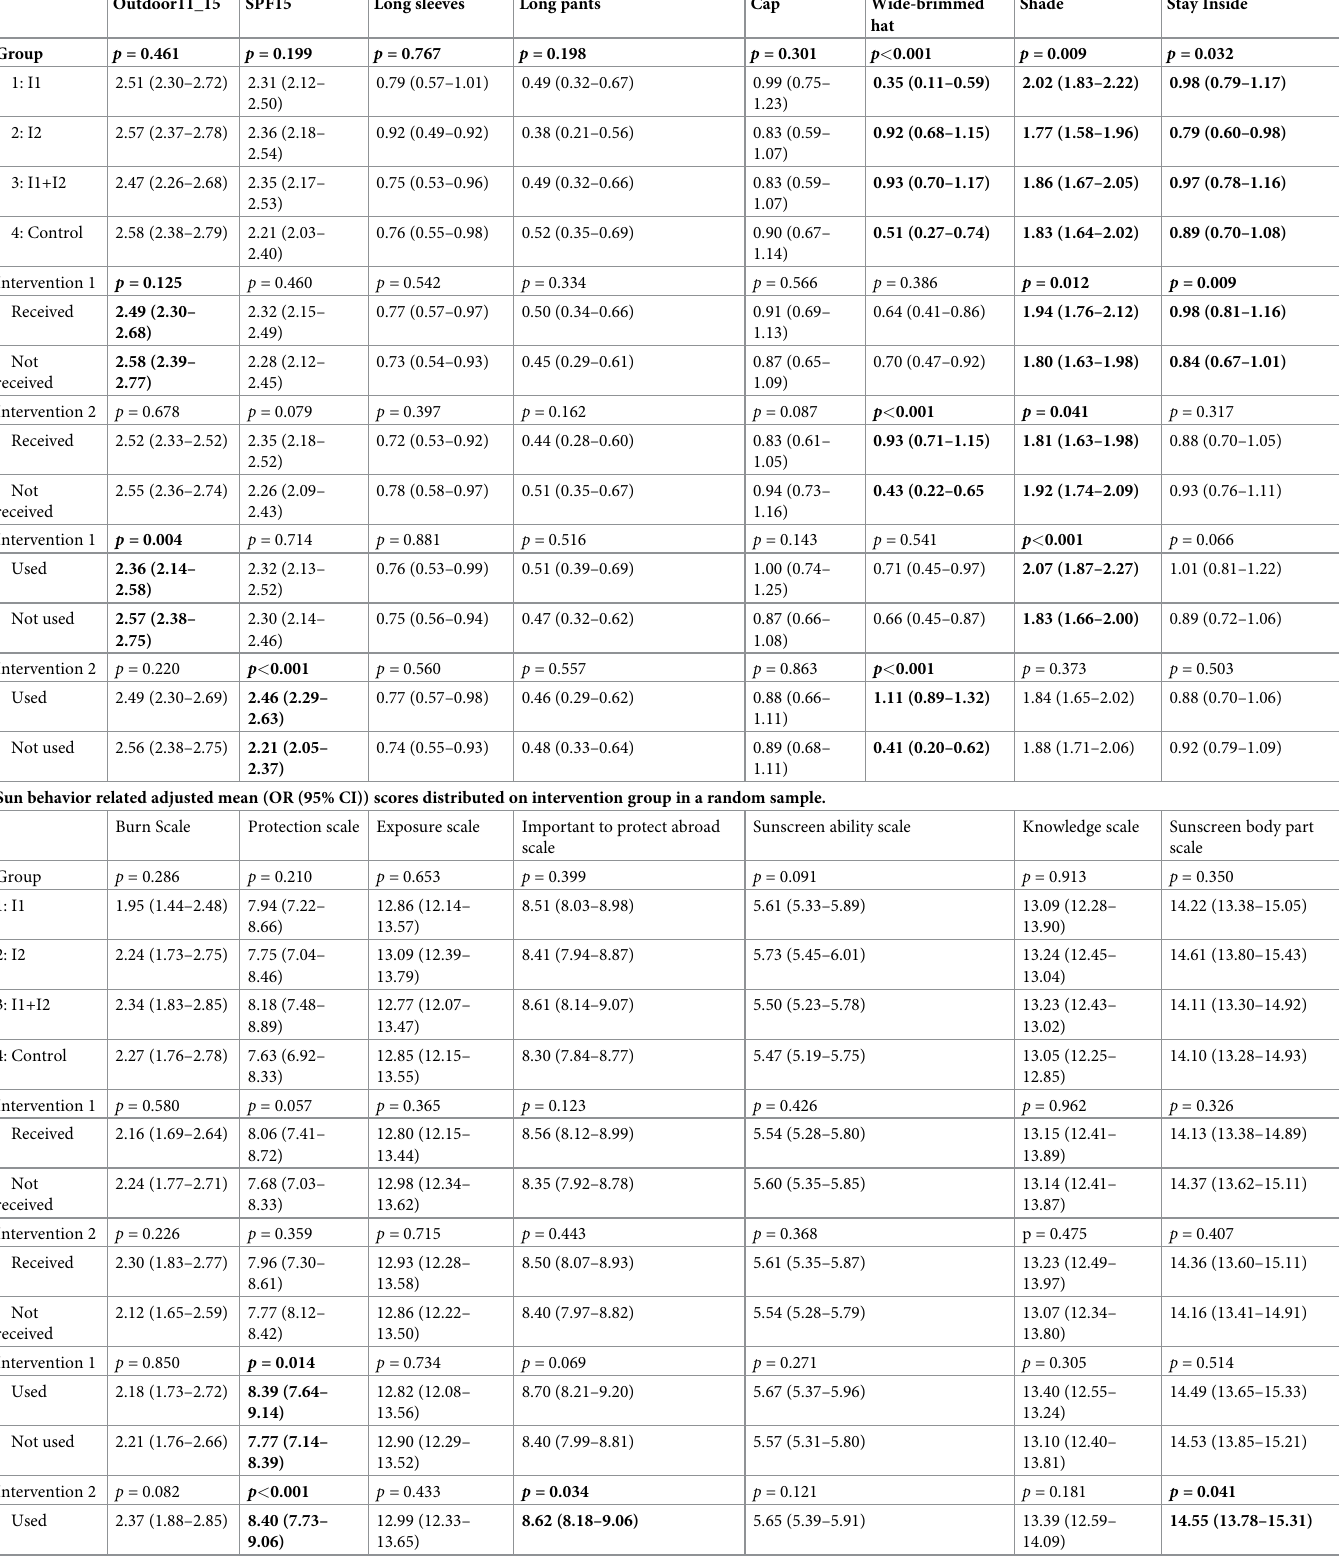
Table 4. Sun behavior related adjusted mean (95% CI) scores distributed on intervention group in a random sample. Outdoor11_15